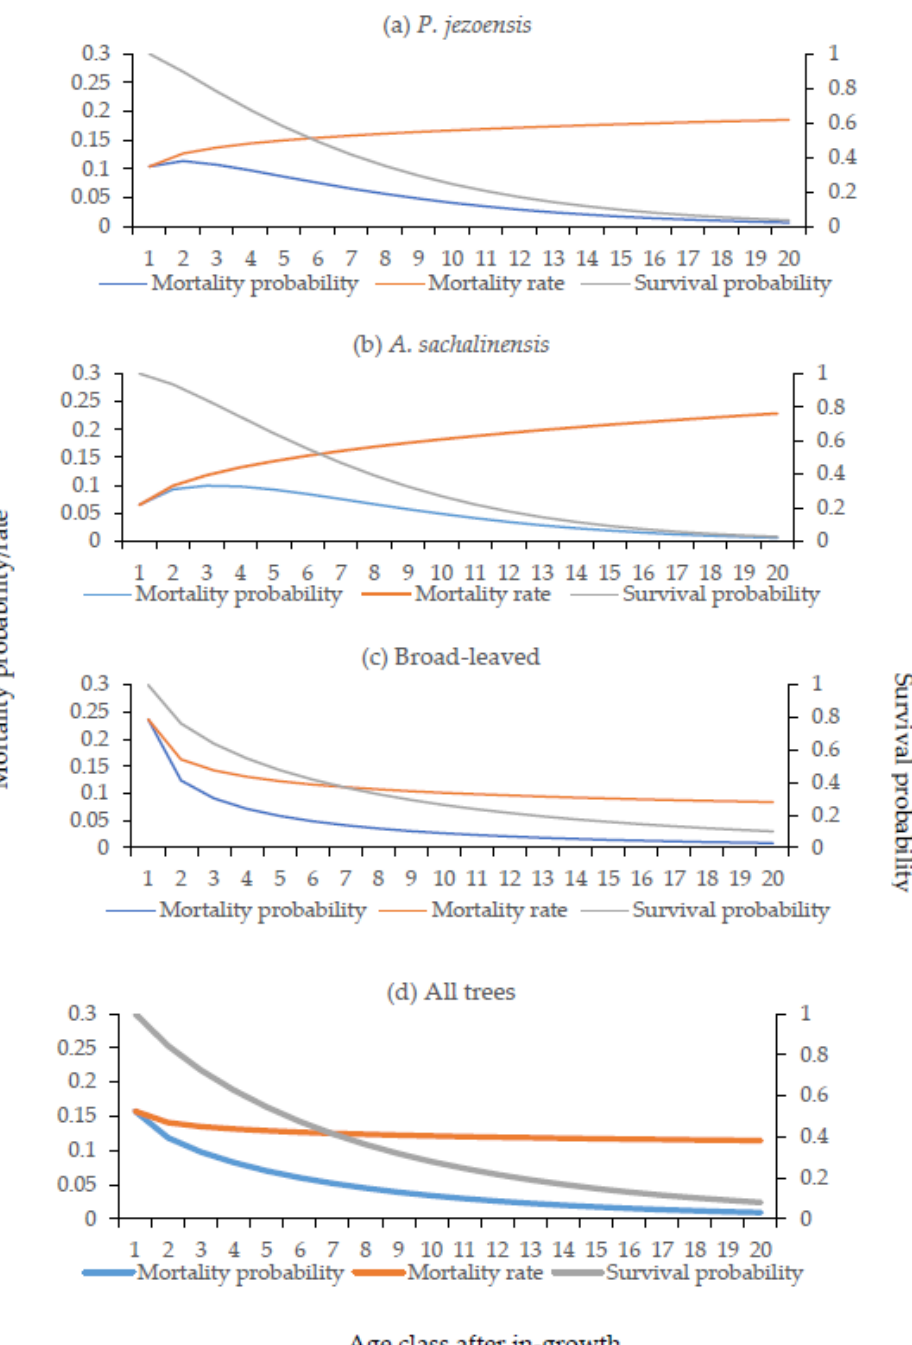
Figure 3. Distribution of tree mortality probability, mortality rate, and survival probability based on Weibull distributions: ( a ) A. sachalinensis , ( b ) P. jezoensis , ( c ) broad-leaved trees, and ( d ) all trees. The living-tree distributions of each category of the previous period were calculated based on the Weibull models of period 3 (Table 5, Figure 4) for validation. Predictions of dead trees are basically underestimated for younger and older age classes and slightly overestimated for the middle class. The resulting living trees and actual tree numbers of each age class were compared in terms of the root mean square error (RMSE) and root mean square percentage error (RMSPE) to determine the validity of the predictions. This exhibited a better prediction power for each category as follows: A. sachalinensis had the lowest RMSE (1.20 living trees) value, whereas all the trees (6.28 living trees) had the